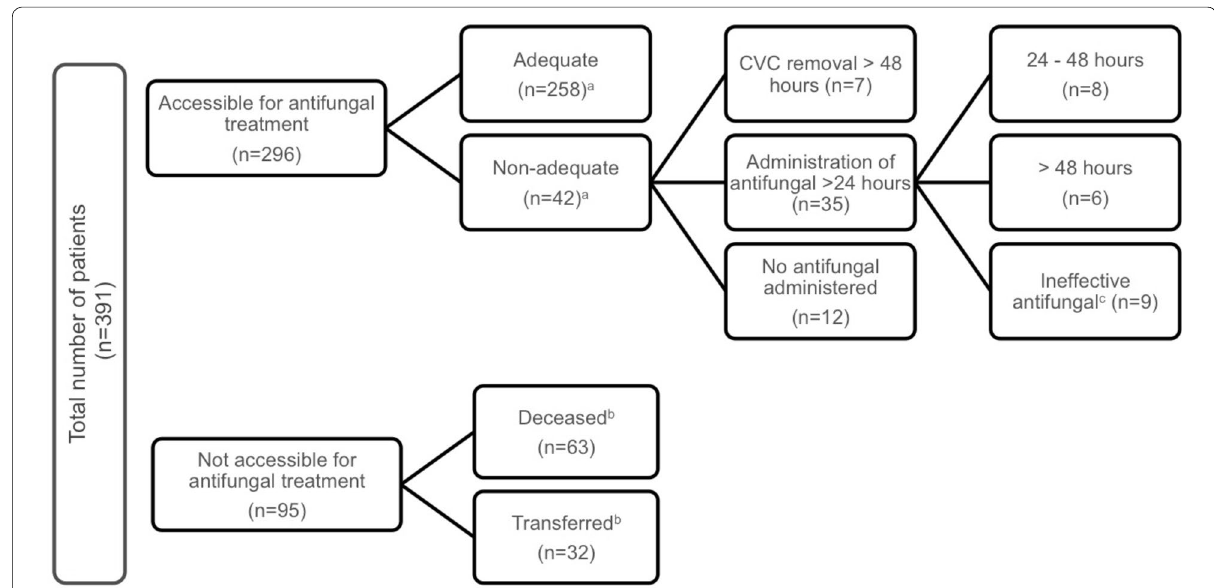
Fig. 3 Antifungal management in 391 critically ill patients with Candida ‑induced bloodstream infection. a Numbers do not add up to 296 because more than one criterion was found in some patients. b Refers to patients, who died or were transferred to another hospital/rehabilitation facility, before microbiological results were obtained. c Candida spp. was not susceptible to antifungal substance